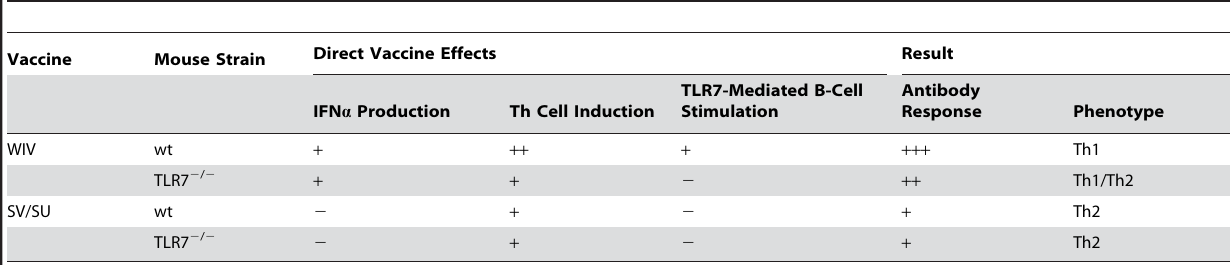
Table 2. Putative vaccine effects contributing to different adaptive immune responses based on the model proposed by Heer et al.